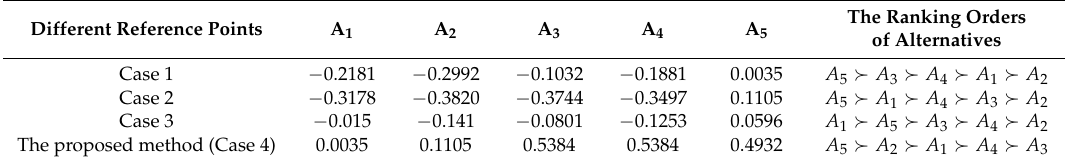
Table 4. The prospect values and rankings of alternatives based on different reference